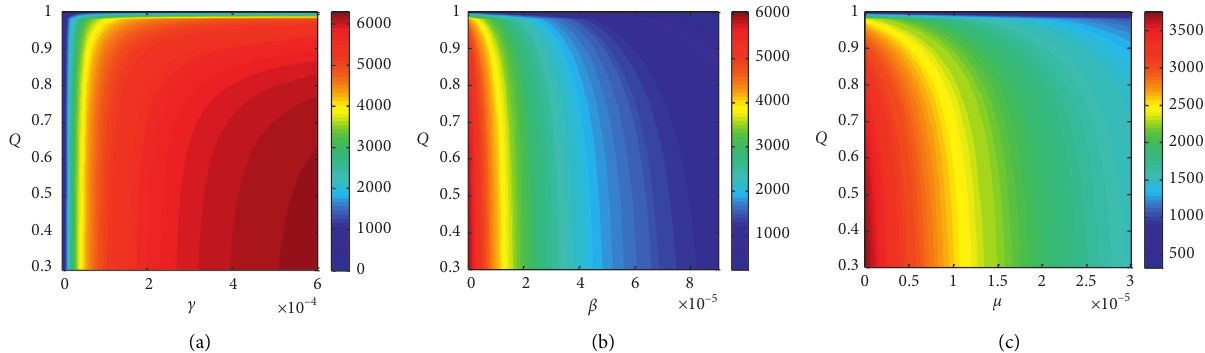
Figure 6: Number of RI nodes with changing Q versus c , β , and μ , respectively. b � 0.8, T � 20000, and the other settings are the same as the default